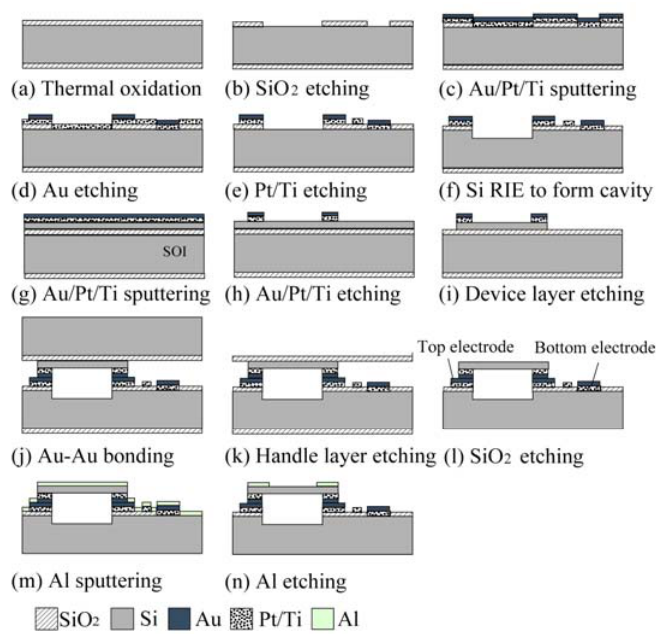
Figure 9. Fabrication process